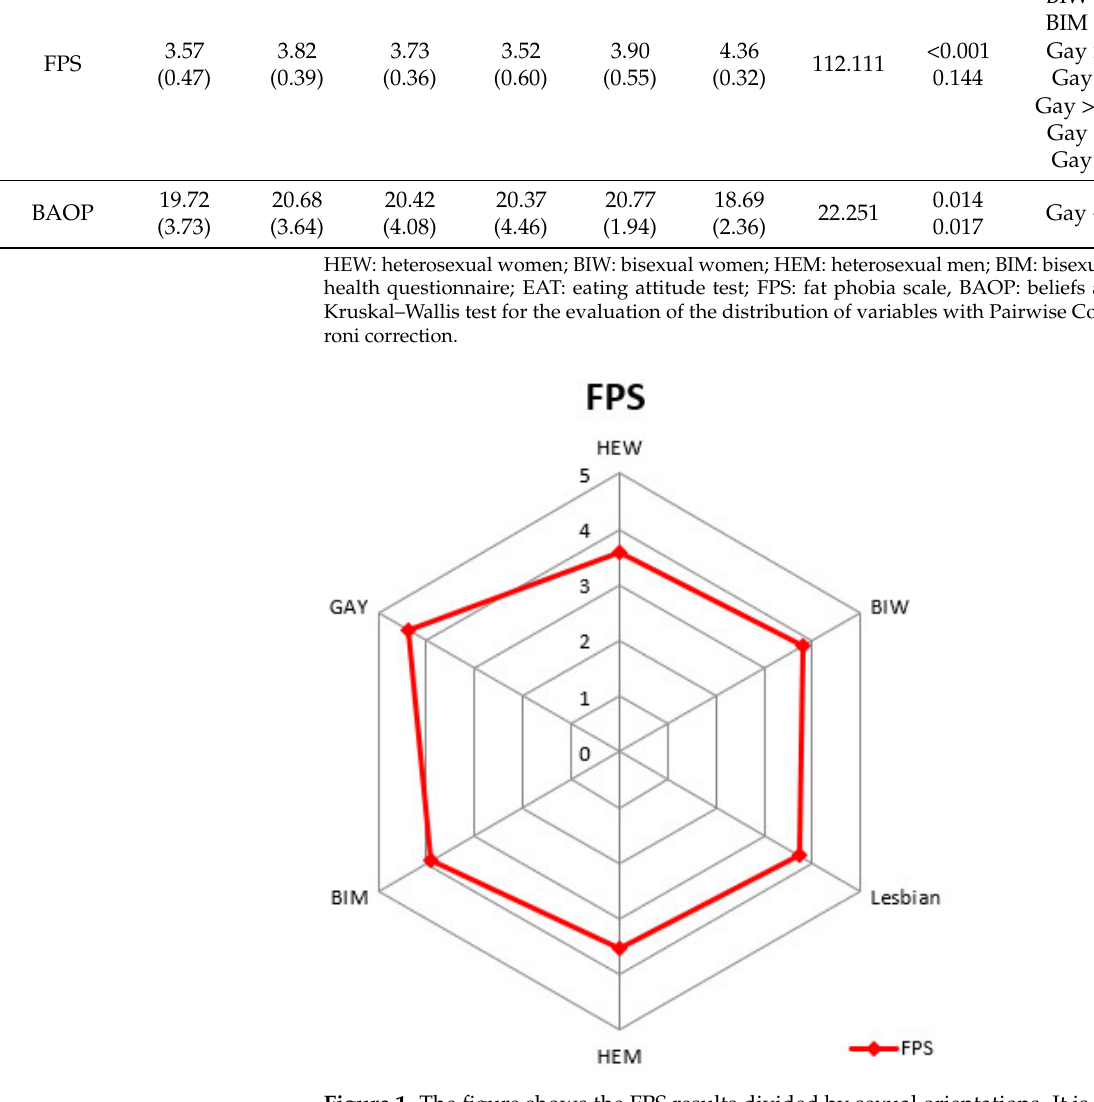
Figure 1. The figure shows the FPS results divided by sexual orientations. It is possible to appreciate how differently the results are distributed in the sexual minority groups of both genders compared to heterosexual peers. Gay men showed the highest scores for fat phobia in all groups included in the study, see Table 2 for Table 2. Psychological evaluation of the sample.